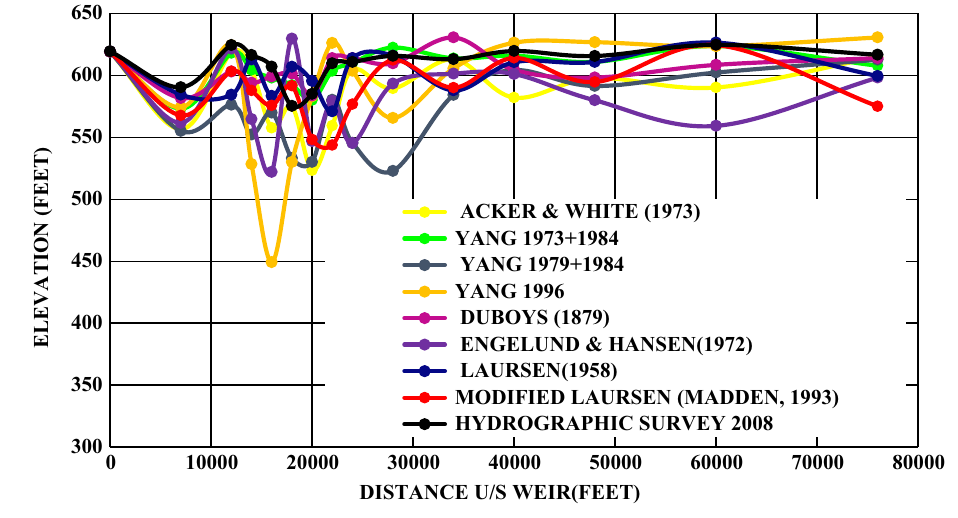
Fig. 3 Performance of various sediment transport functions in estimating the bed levels Fig. 4 Calibration of the model using Yang’s 1973 + 84 sedi- ment transport function for the year